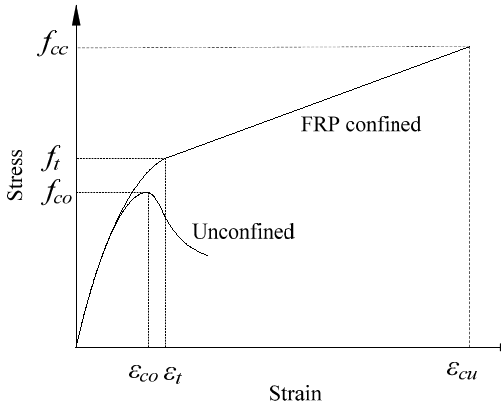
Figure 1. The typical stress-strain curve for FRP-confined concrete with strain-hardening.